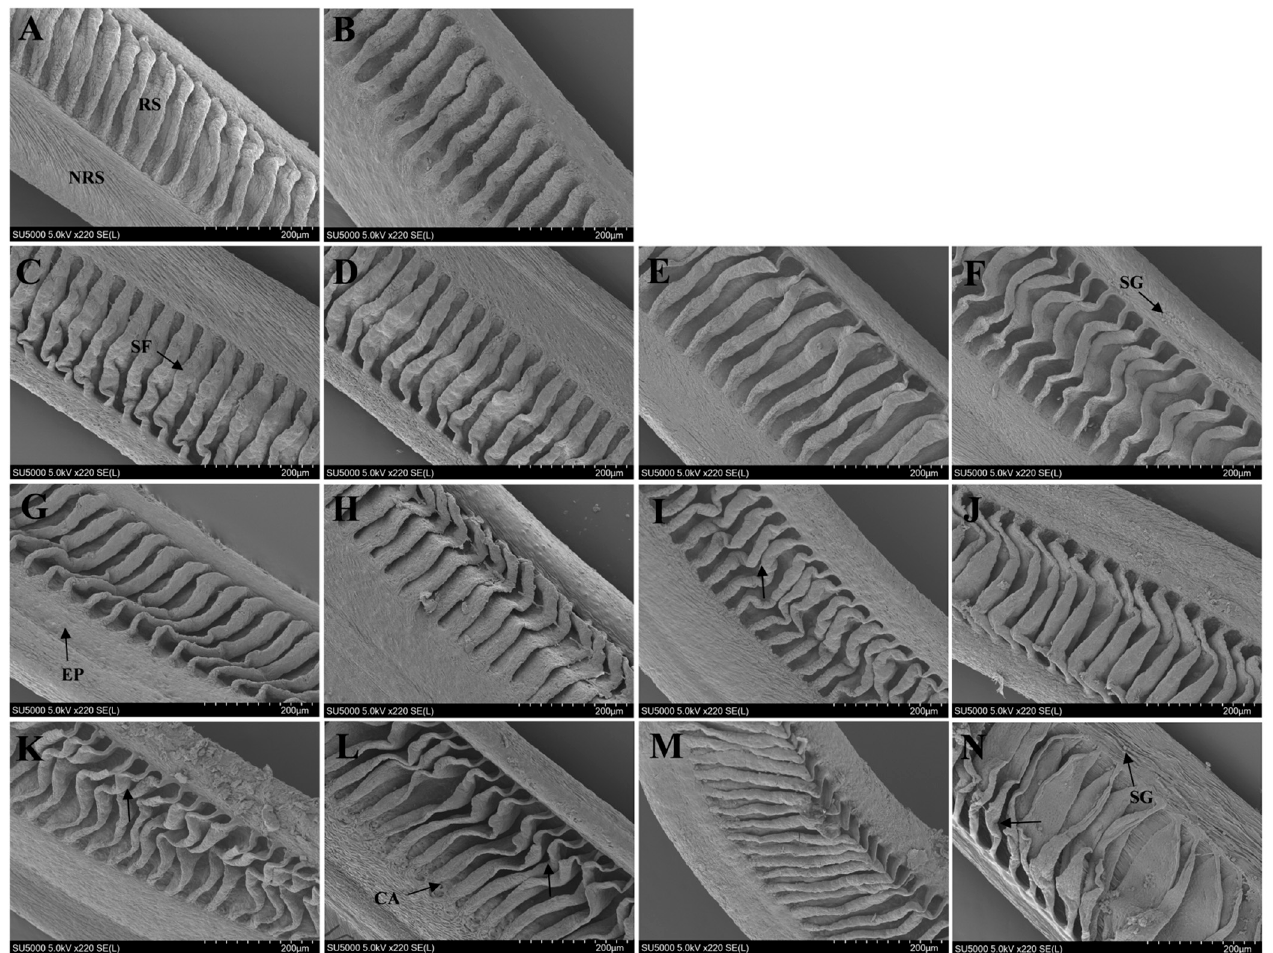
Figure 7. Representative SEM micrographs showing changes in gill structure after di ff erent temperatures and vibration rates. ( A ) 15 °C, ( B ) 25 °C, ( C ) 24 h—15 °C, ( D ) 24 h—25 °C, I 24 h—15 tures and vibration rates. ( A ) 15 ◦ C, ( B ) 25 ◦ C, ( C ) 24 h—15 ◦ C, ( D ) 24 h—25 ◦ C, I 24 h—15 ◦ C/70 rpm, °C/70 rpm, ( F ) 24 h—25 °C/70 rpm, ( G ) 24 h—15 °C/120 rpm, ( H ) 24 h—25 °C/120 rpm, ( I ) 48 h—15 ( F ) 24 h—25 ◦ C/70 rpm, ( G ) 24 h—15 ◦ C/120 rpm, ( H ) 24 h—25 ◦ C/120 rpm, ( I ) 48 h—15 ◦ C, ( J ) °C, ( J ) 48 h—25 °C, ( K ) 48 h—15 °C/70 rpm, ( L ) 48 h—25 °C/—70 rpm, ( M ) 48 h—15 °C/120 rpm, 48 h—25 ◦ C, ( K ) 48 h—15 ◦ C/70 rpm, ( L ) 48 h—25 ◦ C/—70 rpm, ( M ) 48 h—15 ◦ C/120 rpm,